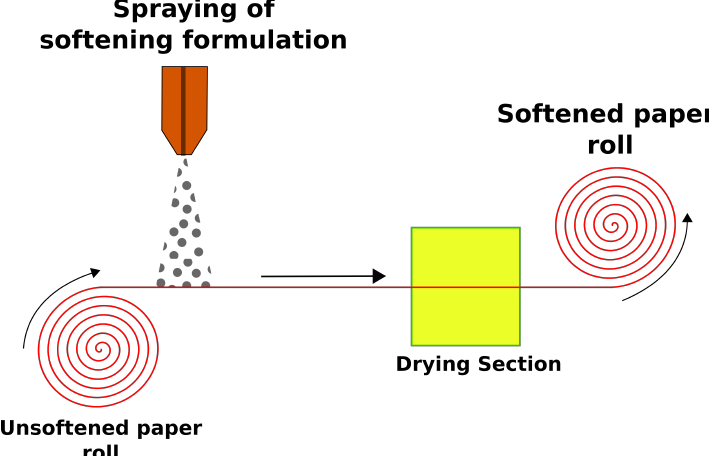
Figure 1. Schematic representation of a typical paper softening process as carried out in